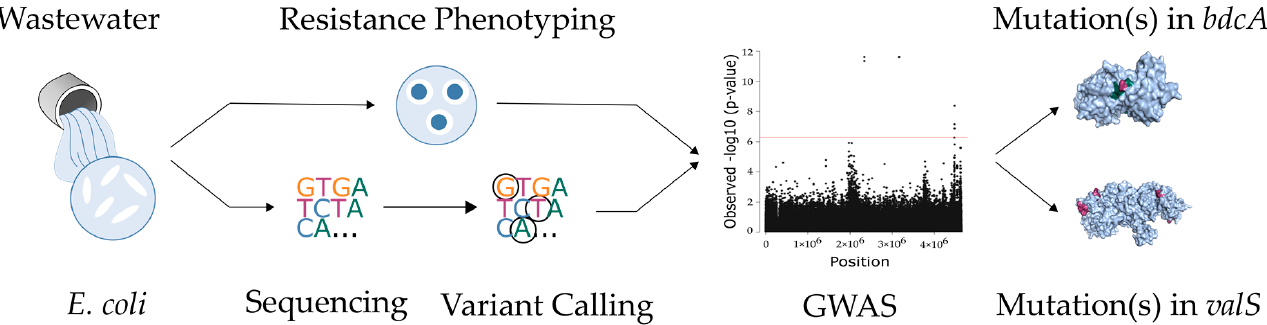
Figure 1. Wastewater E. coli were phenotyped and sequenced. Variants were called and correlated to quinolone resistance in a GWAS study resulting in novel candidate resistance